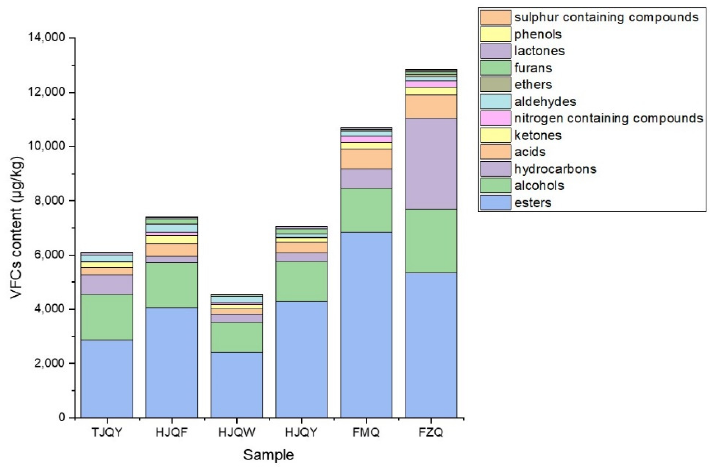
Figure 5. Contents of volatile flavor compounds in six JIUYAOs.